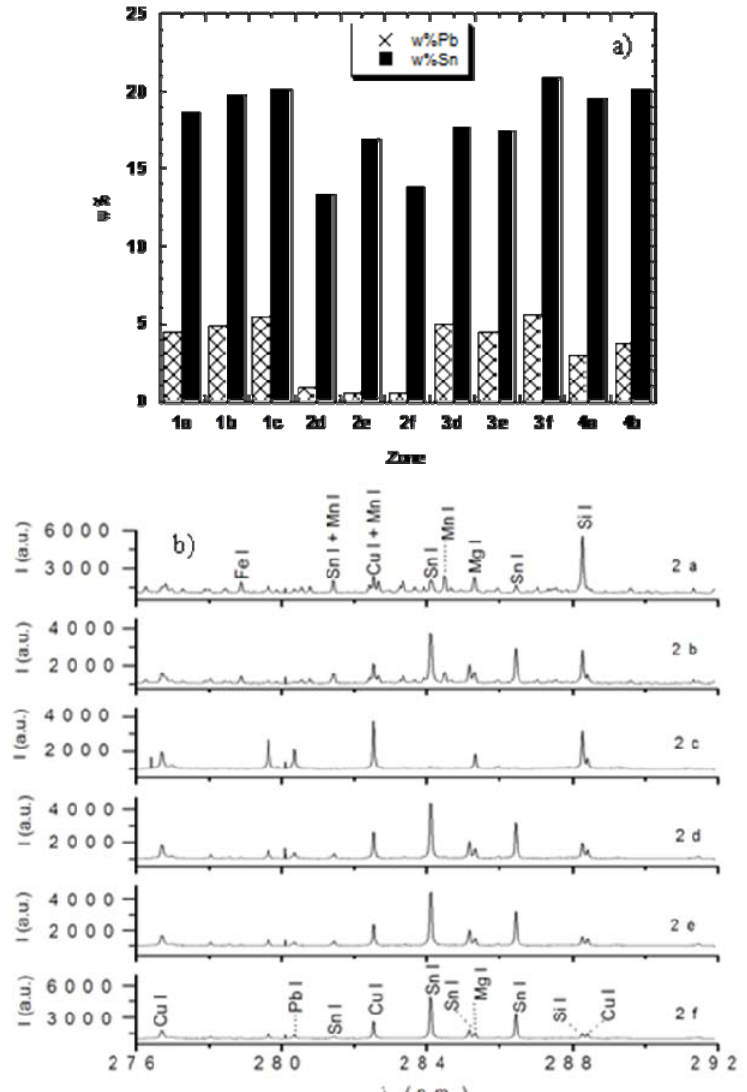
Figure 3. (a) Bar charts of Sn and Pb weight percentages at increasing sampling depth